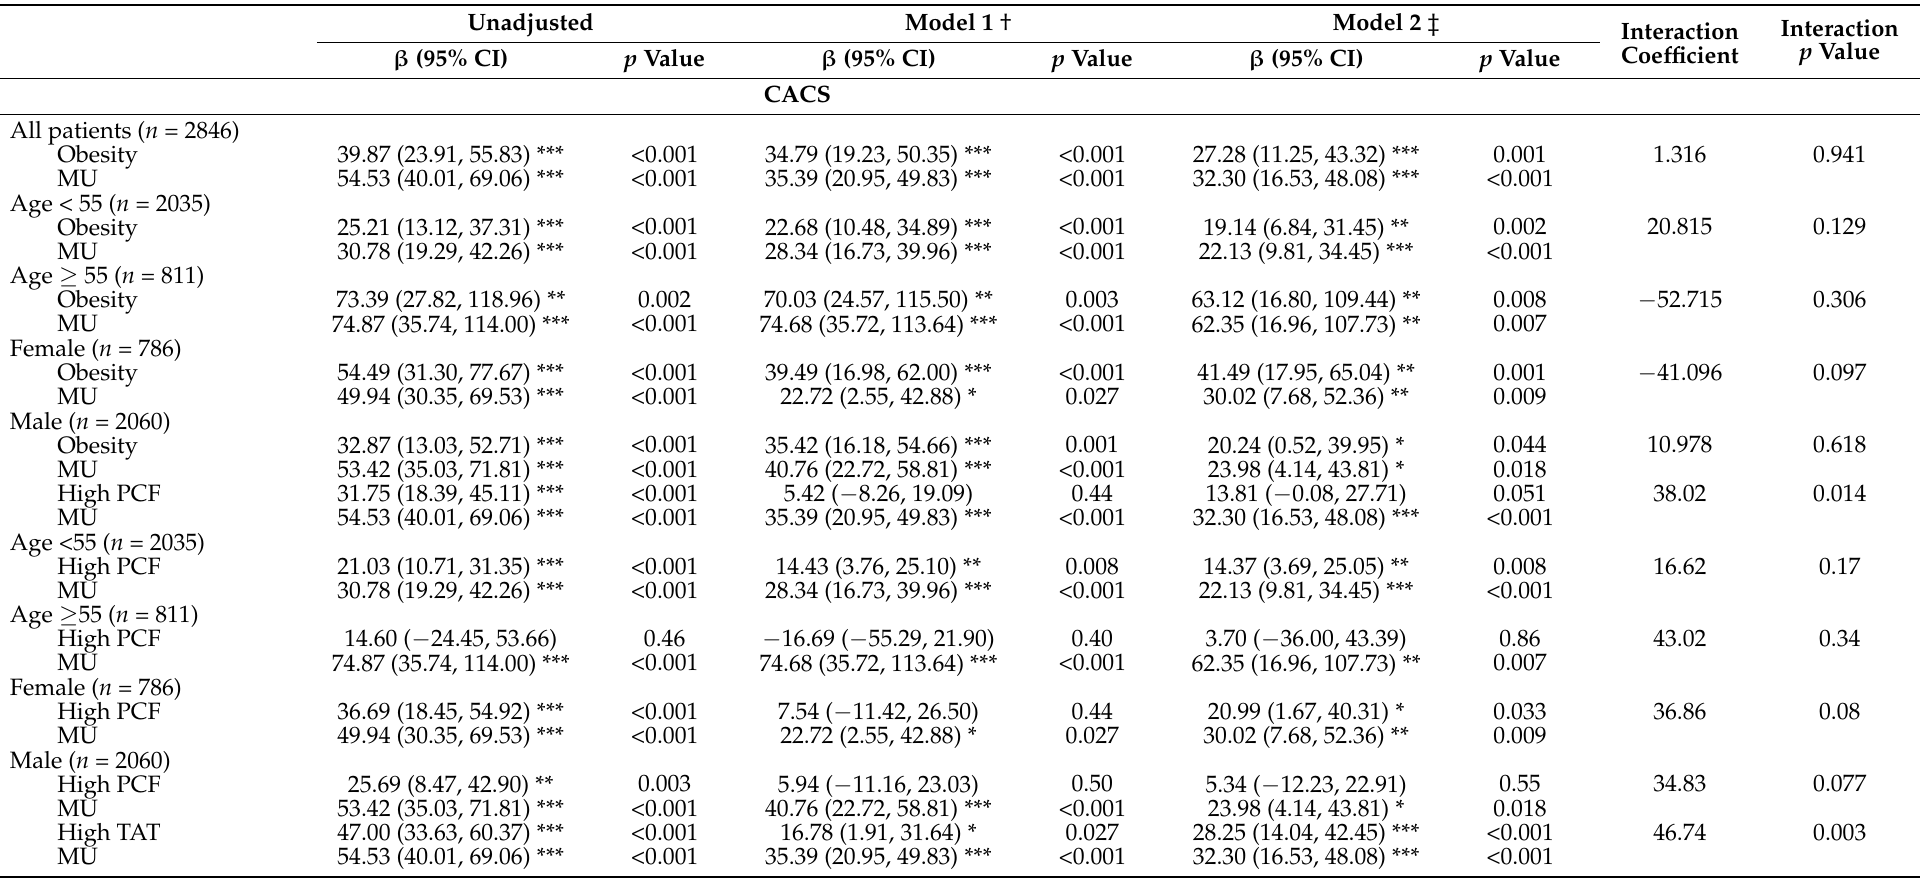
Table 3. Associations between obesity, visceral adiposity, MU, and CAC burden (according to the